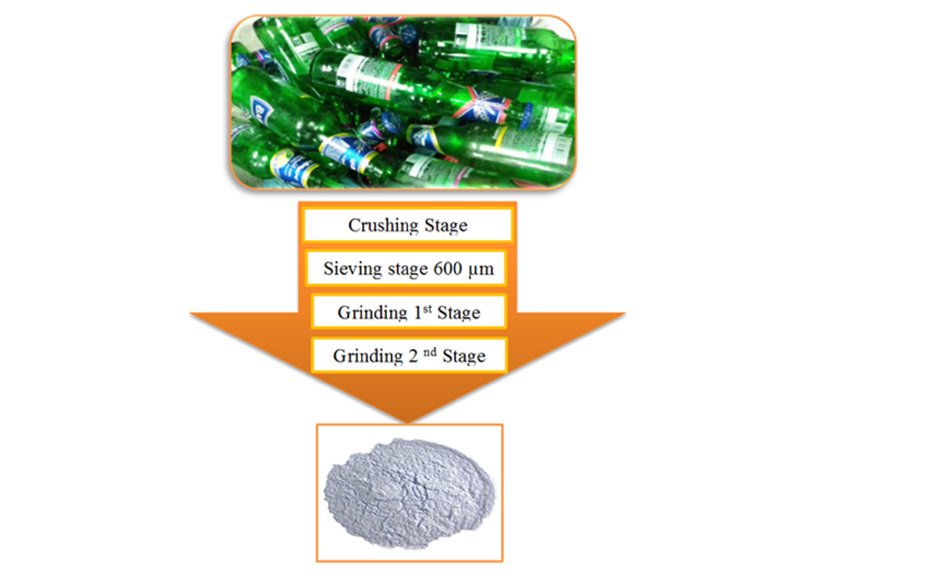
Table 1. Chemical compositions of BGWNP, GBFS, and FA, mass